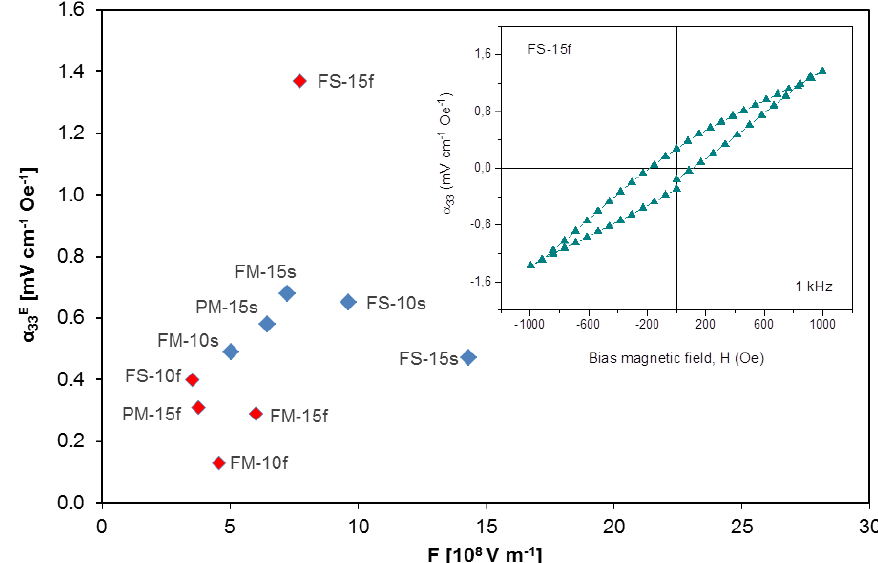
Figure 9. Magnetoelectric coe ffi cient α 33 E vs. figure of merit F (all samples). Red diamonds: fast sintered samples; blue diamonds: slow sintered samples. In the inset, an α 33E - H loop for the FS-15f sample is shown between −10 3 and +10 3 Oe bias magnetic field.